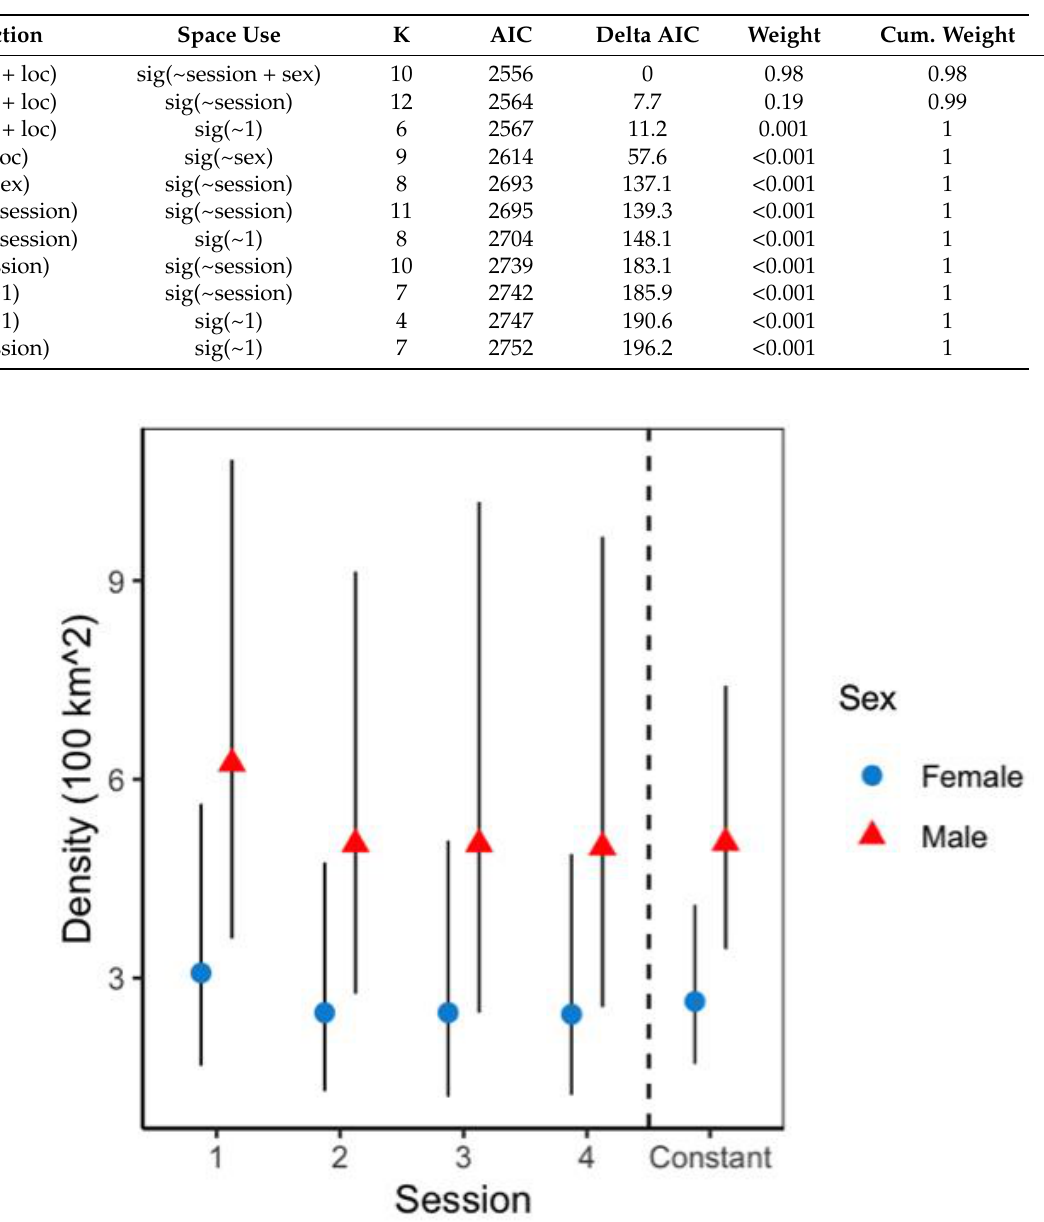
Table 3. Model selection results for 11 candidate models analyzed including: session effects (session), male/female sex effect (sex), trail/off trail camera location (loc) and constant effect (~1), in Sector Santa Rosa, Guanacaste Conservation Area, Northwestern Costa Rica.